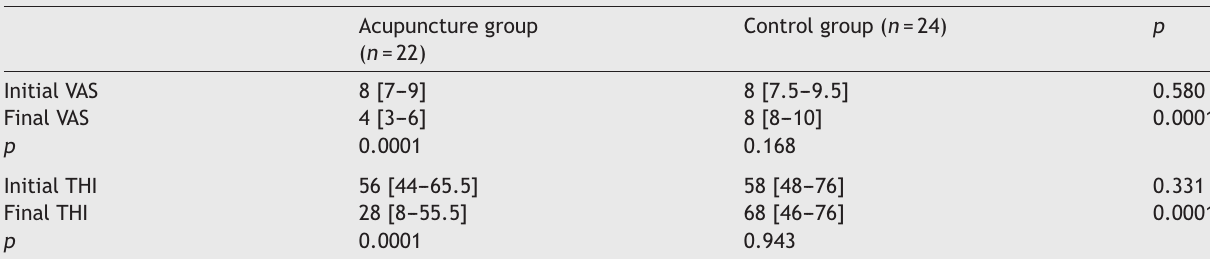
Primary and secondary endpoint, and comparison between